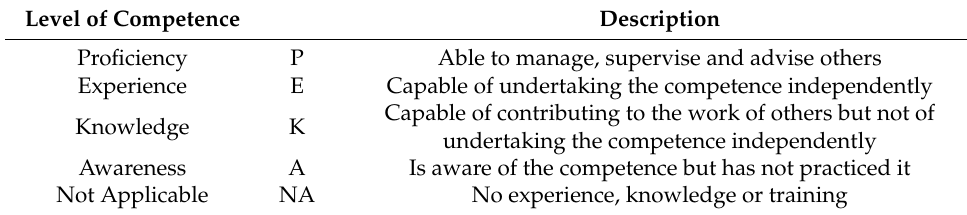
Table 2. Competence levels.